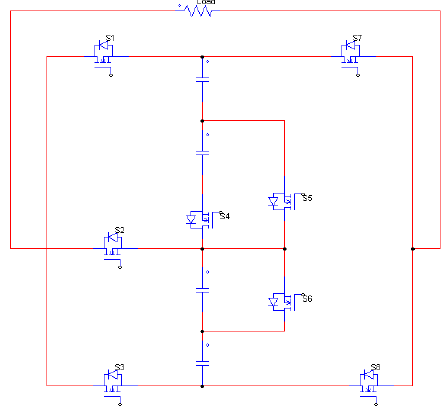
Figure 21. Multilevel inverter to reduce switching losses.